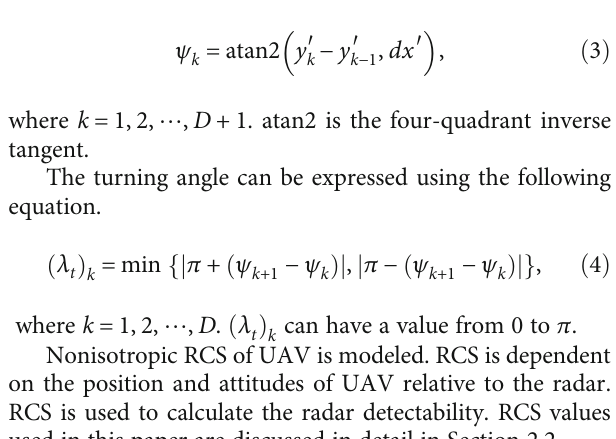
and λ t are the minimum turning radius and min (cid:4)(cid:4)(cid:4)(cid:4)(cid:4)(cid:4)(cid:4) ! WP k in a new coordi- The heading angle ( ψ ) for WP k − 1 nate system can be expressed using the following equation.